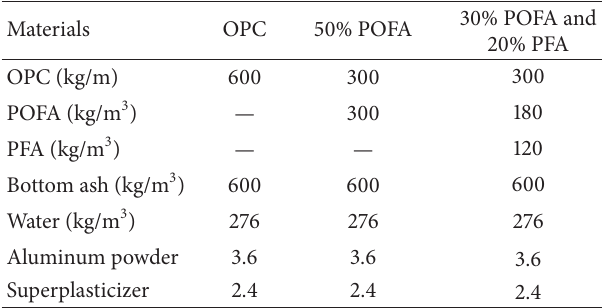
Table 2: Physical properties of OPC, POFA, and PFA. Table 3: Mix proportions of OPC and POFA-PFA aerated